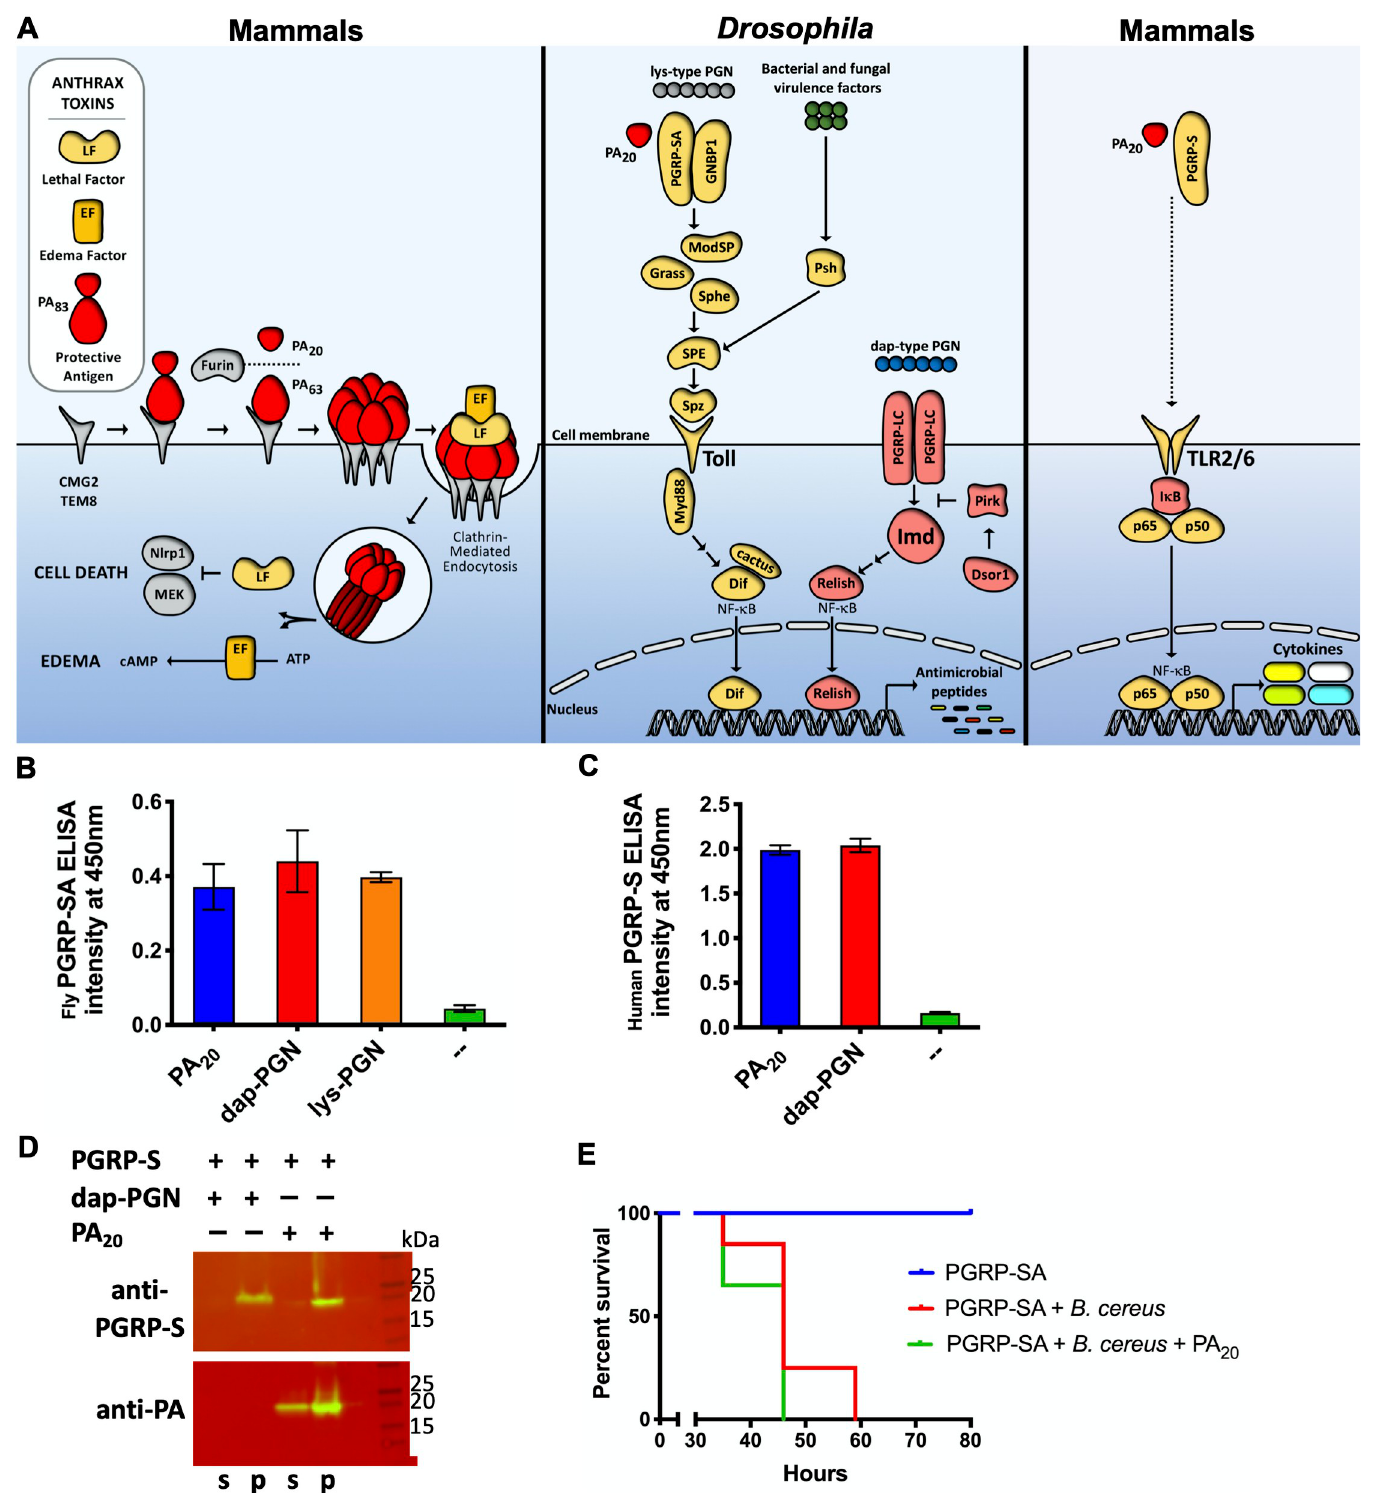
Fig 5. Fly PGRP-SA interacts with PA 20 and is necessary for PA 20 -mediated protection. (A) A model of PA 20 -mediated phenomenon. During mammalian anthrax infection (left panel), anthrax PA 83 binds to host CMG2 and TEM8 cell surface receptors. PA 83 is then cleaved by cell surface mammalian furin proteases, yielding PA 20 and PA 63 , with the latter remaining attached to the host cell receptor. PA 63 then multimerizes and binds to the circulating LF or EF molecules. This PA pre-pore is